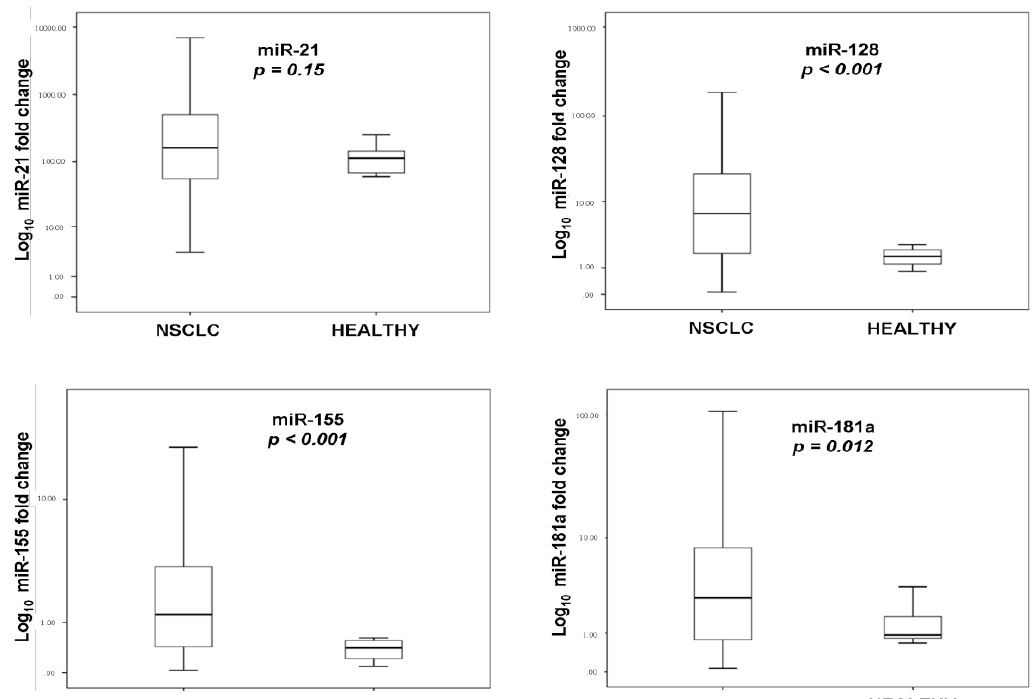
Figure 2. Fold change of four miRNAs expression in plasma of non-small cell lung cancer (NSCLC) (n = 128) patients treated with first-line chemotherapy and healthy donors (n = 19). Expression levels of four miRNAs relative to U6 snRNA was assessed by the 2 −ΔCt method. Mann – Whitney test was used to determine statistically significant differences, and the results are displayed on box plots. Horizontal line depicts median, whereas the length of the boxes is the interquartile range that represents values between the 75th and 25th percentiles of individual fold change expression values. Relative expression values on the y -axis are plotted on a log 10 scale. p values are shown.